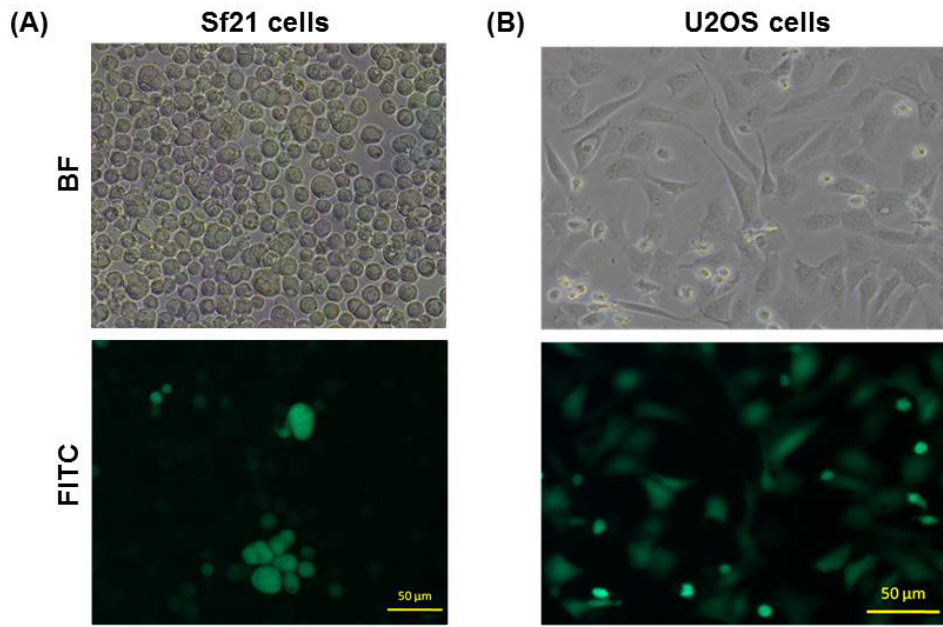
Figure 6. ( A ) Production and analysis of BacMam vector, vAc-CMV-CHIKV NS-EGFP in Sf21 insect cells at a multiplicity of infection (MOI) of 10 and ( B ) BacMam transduced to U-2OS cells (5 × 10 3 cells seeded in a 24-well plate) at MOI 10. The BacMam transfection in Sf21 and transduction in U-2OS cells at 2 (dpi and dpt) were examined under a fluorescence microscope with a FITC channel (lower panel) and a bright field (upper panel) at 450/490-nm filter set using an exposure time of 1 s. The bar represents 50